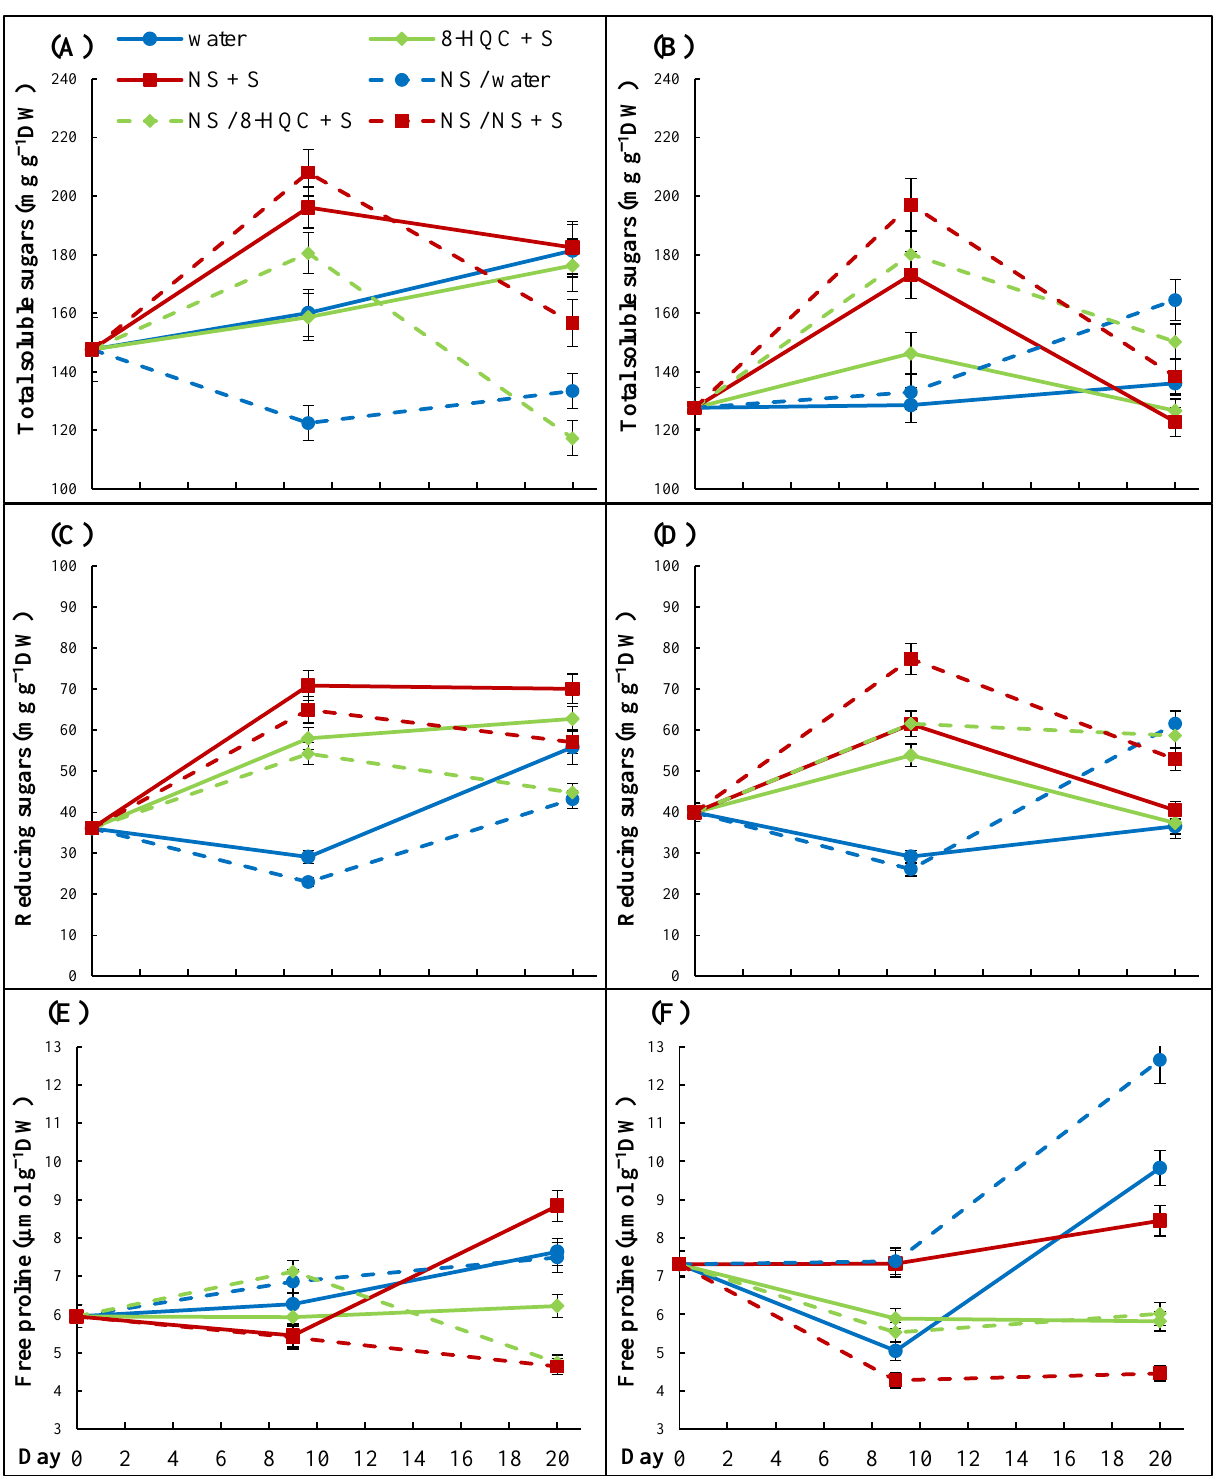
Figure 3. Total sugar contents ( A , B ), reducing sugars contents ( C , D ), and free proline contents ( E , F ) in the lower ( A , C , E ) and the upper ( B , D , F ) flowers of cut lisianthus. Values are expressed as the mean ± SD. Vertical bars represent standard deviations of the means.